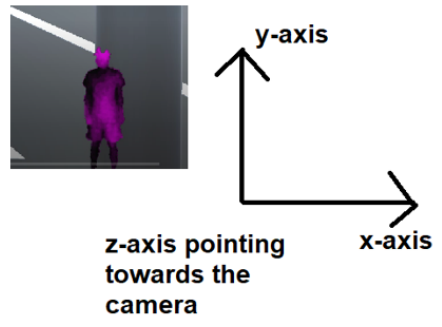
Figure 11. Coordinate system of the joints for Kinect sensor.